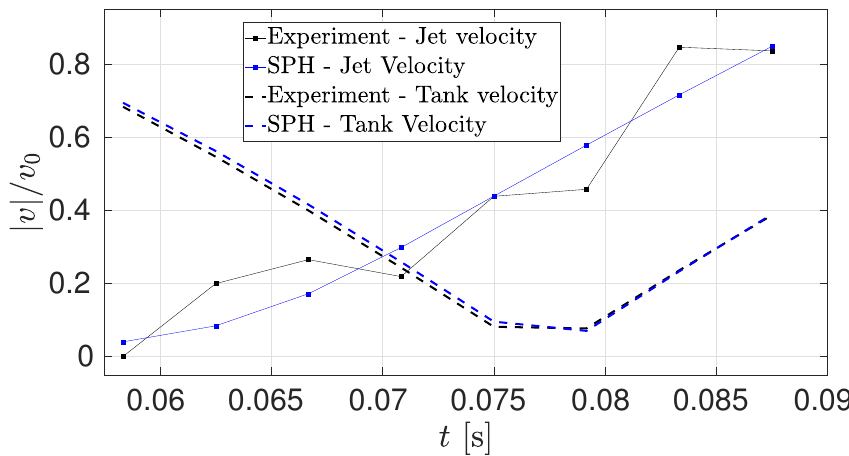
Figure 11. Non-dimensional velocity magnitude of the central jets measured from the SPH computa- tion and the experimental snapshots. The decreasing tank velocity is also plot to have a reference for the jet evolution.